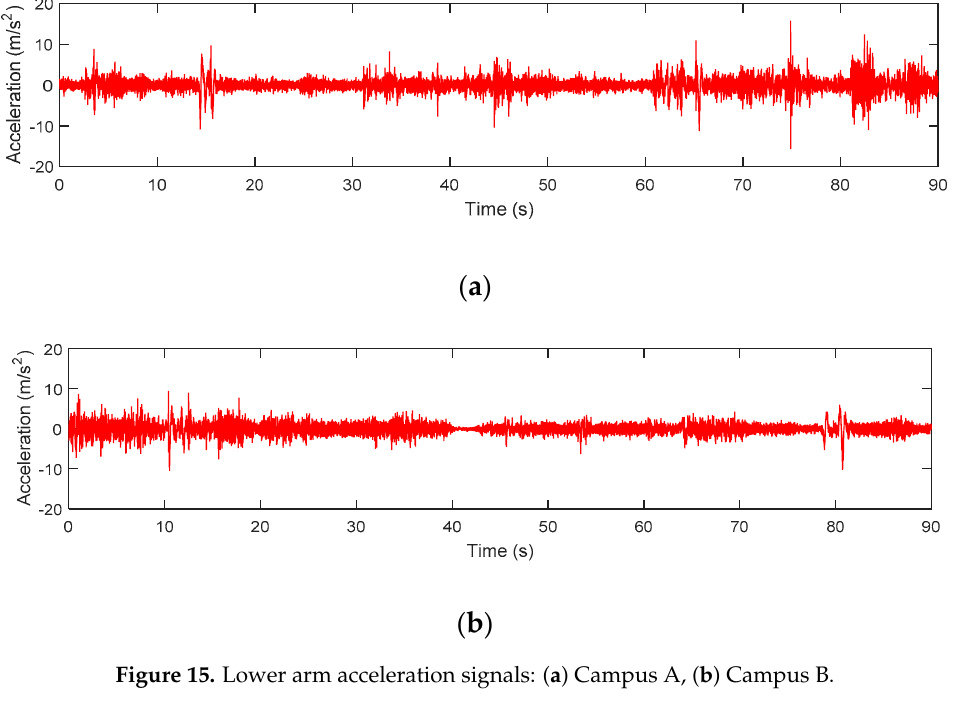
Figure 14. Top mount acceleration signals: ( a ) Campus A, ( b ) Campus B.